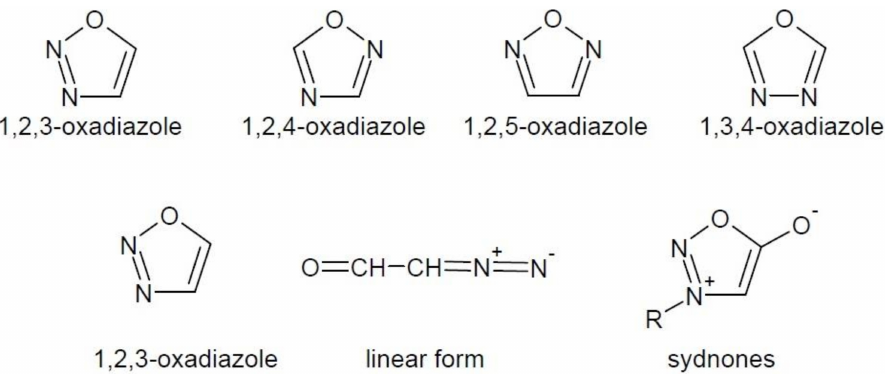
Figure 1. Isomeric forms of oxadiazole and modifications of unstable ring of